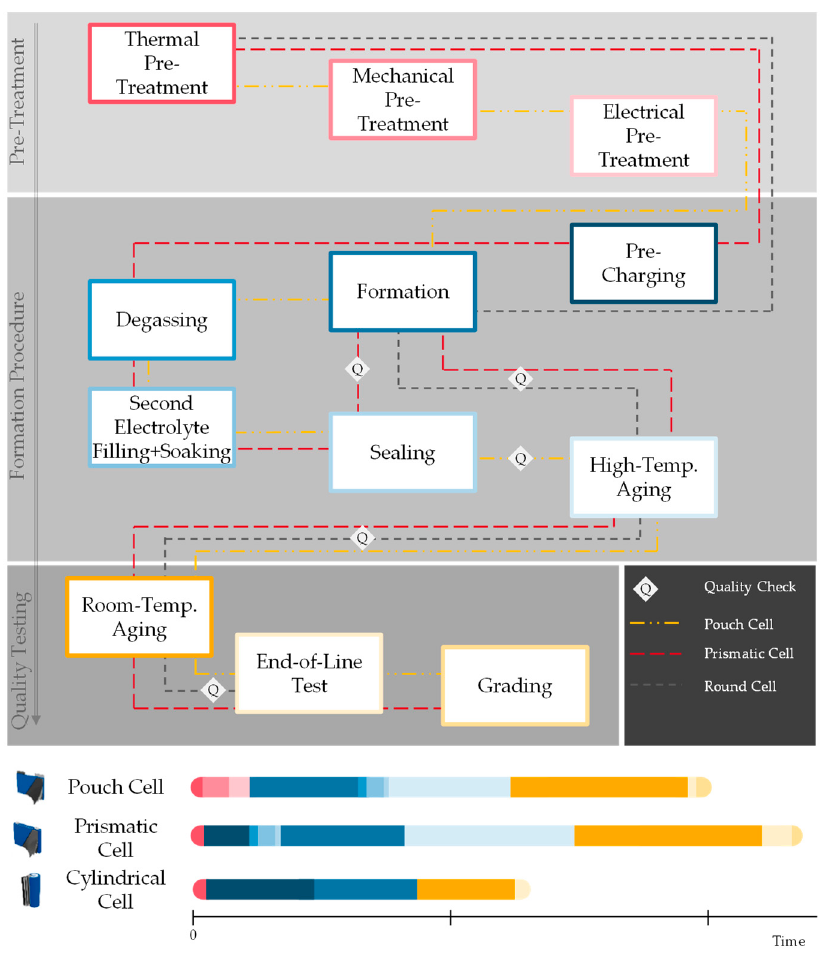
Figure 2. Introduction of possible cell finishing process routes (authors’ illustration) .